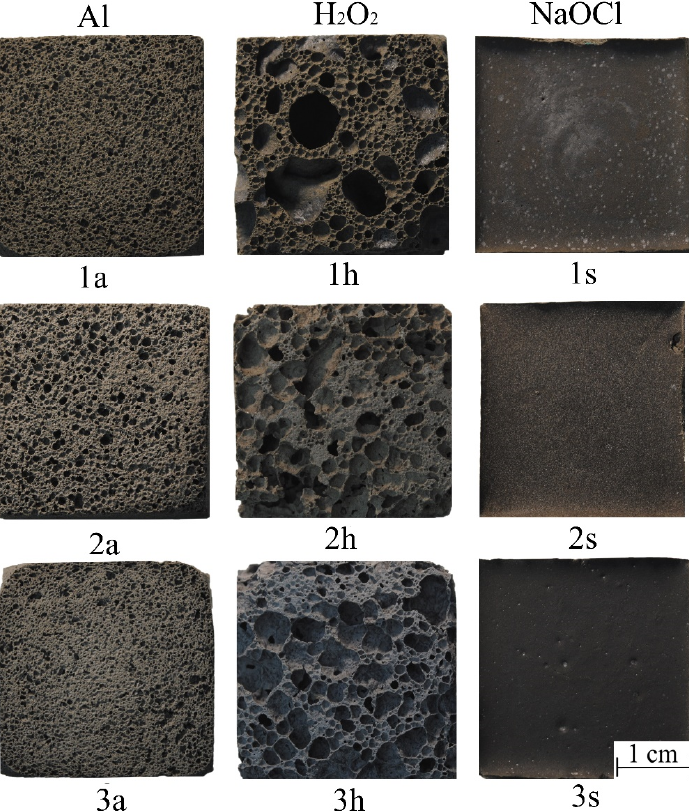
Figure 5. Structure of synthesized porous geopolymers: 1—fly ash, 2—slag, 3—ash and slag waste; a—aluminum powder, h—hydrogen peroxide, s—sodium hypochlorite.